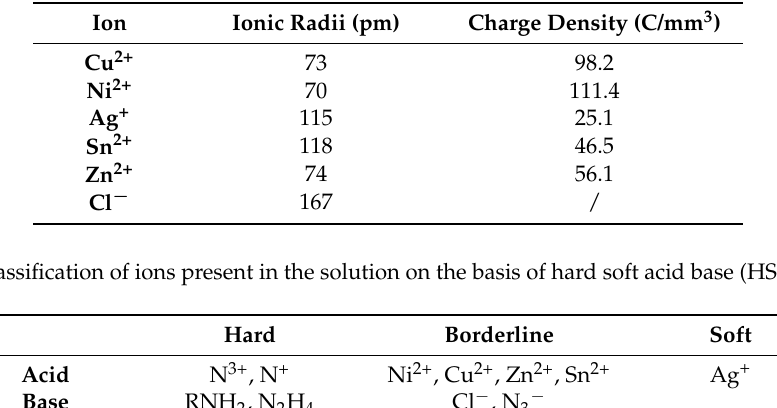
Table 4. The charge density of metal complexes in this work [25,26].